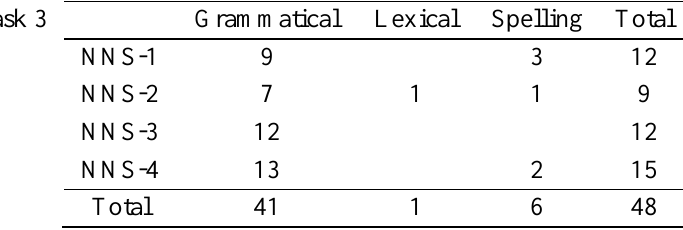
Number of errors in ACMC